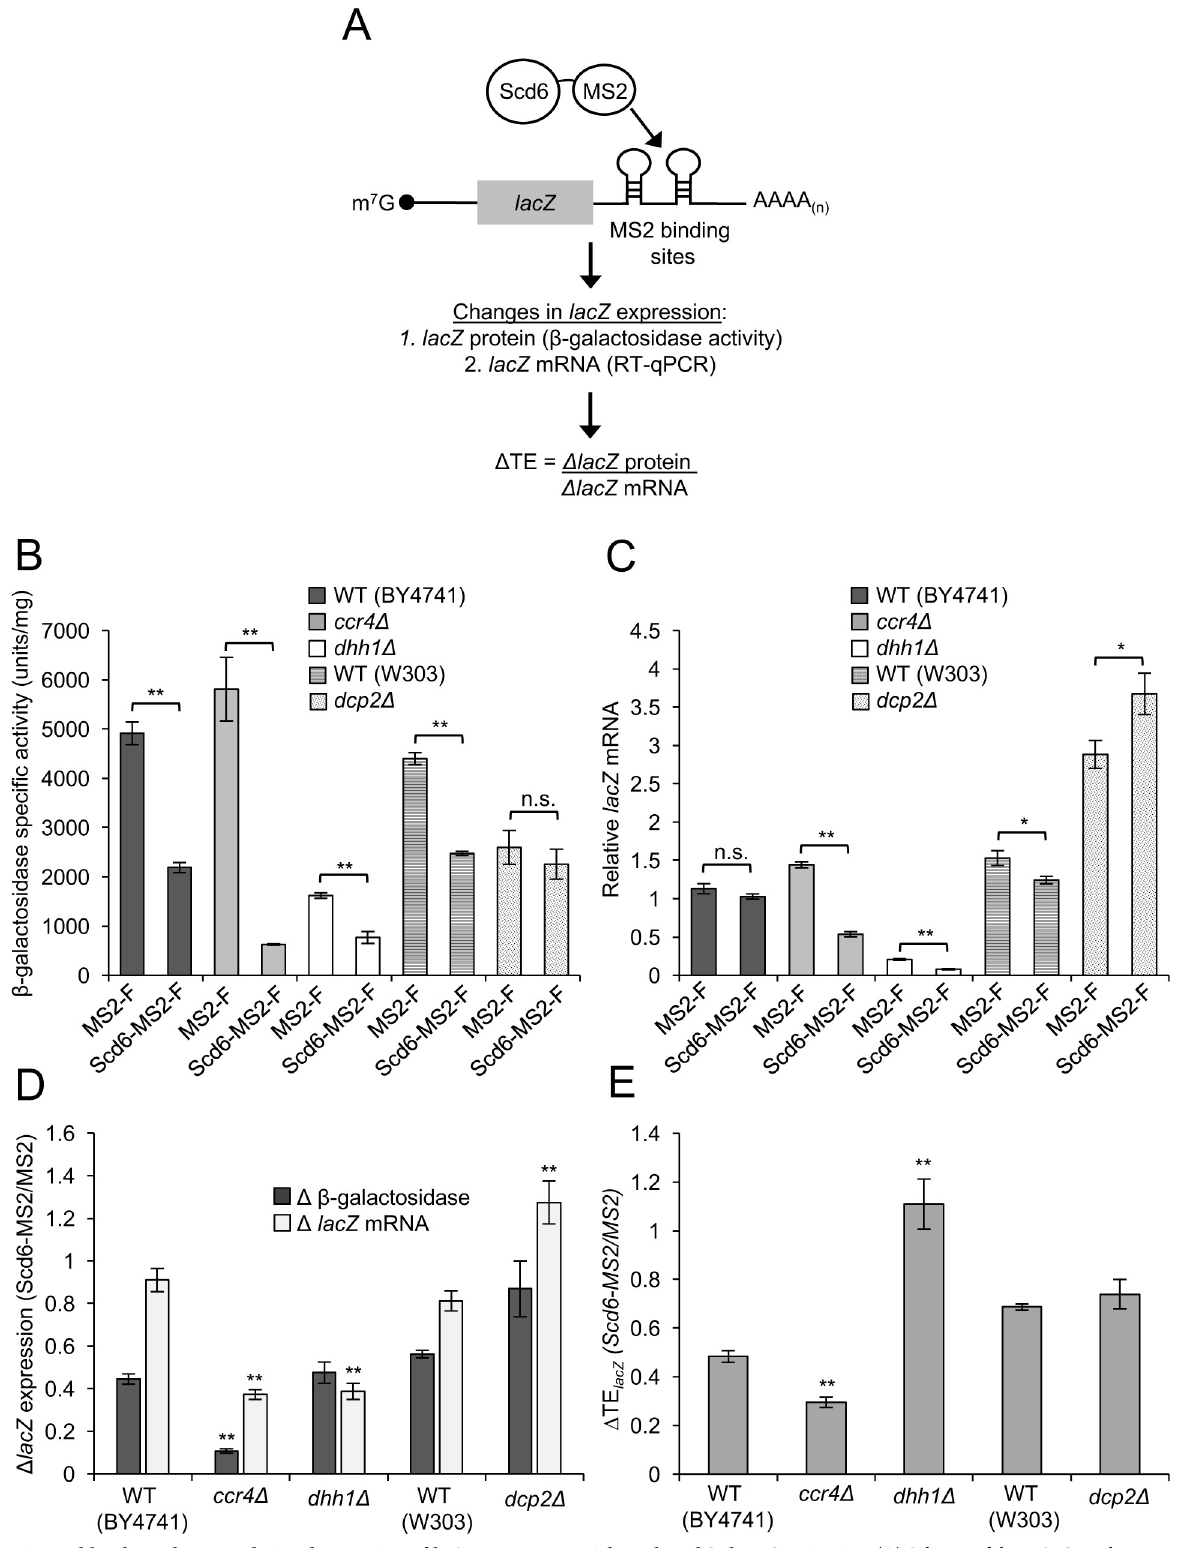
Fig 5. Dhh1-dependent translational repression of lacZ reporter mRNA by tethered Scd6-MS2-F in vivo . (A) Schema of the MS2CP tethering system, as in Fig 1A, for a lacZ versus GFP reporter mRNA. (B-C) Transformants of WT strains BY4741 or HFY114 (W303 background), as